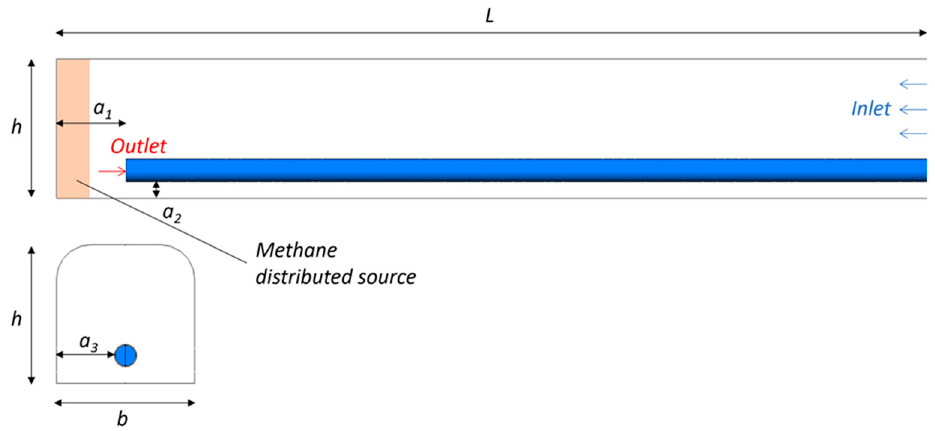
Figure 1. The geometric model.